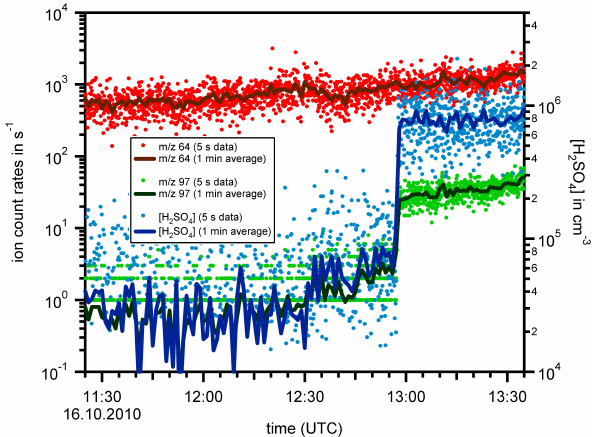
Fig. 4. Time series of the primary ion signal NO 18 O − ( m / z 64), the 2 HSO − ion ( m / z 97) and the derived H 2 SO 4 concentrations from 4 the signals. SO 2 at 1 ppmv was introduced into the sample gas at 12:30; H 2 SO 4 was generated around 12:57 with a calibration set- up external to the CIMS instrument. Please note that the data for m / z 97 and [H 2 SO 4 ] includes many points showing values of zero, which are not visible on the logarithmic scale used